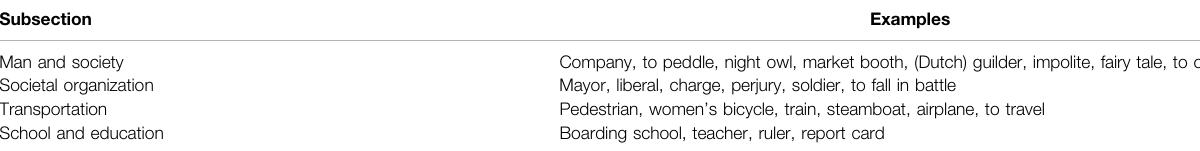
TABLE 5 | Examples of concepts in the subsections of the Society and education